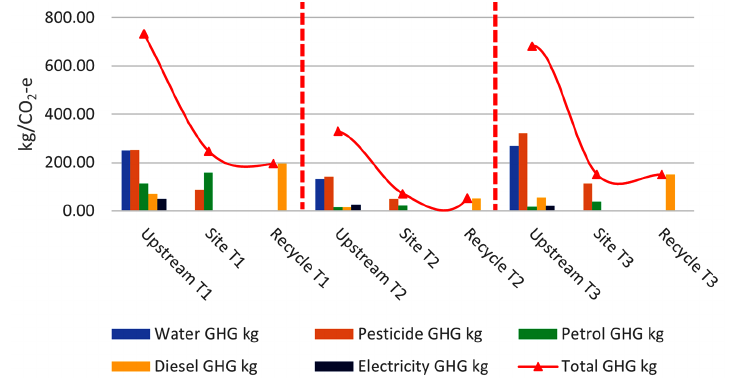
Figure 6. Life cycle of GHG emissions in natural cemetery green space